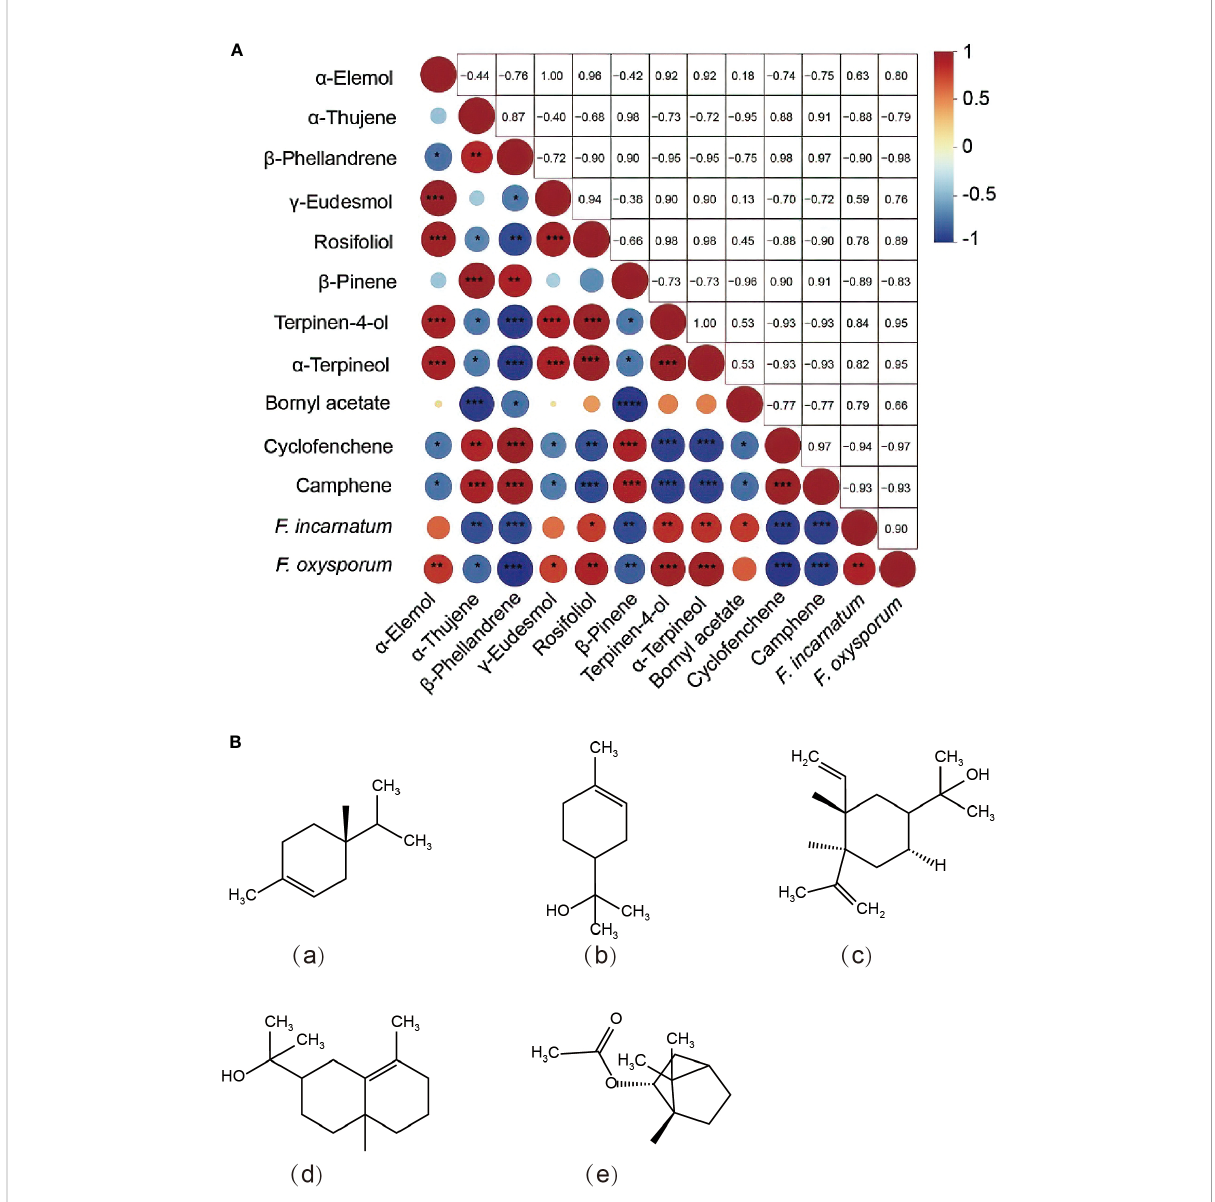
FIGURE 5 (A) Spearman ’ s correlation between variable importance in projection (VIP >1) contents and antifungal activity. Blue circles represent negative correlations, and red circles represent positive correlations. Circles with red and blue represent negative and positive correlations, respectively, and sizes represent the compound contents. (B) Structures of the related components found in the essential oils of Sabina chinensis leaves: (a) terpinen-4-ol; (b) a -terpineol; (c) a -elemol; (d) g -eudesmol; (e) bornyl acetate. The signi fi cance symbol “ * ” indicates a signi fi cant difference (*, P < 0.05; **, P < 0.01; ***, P <